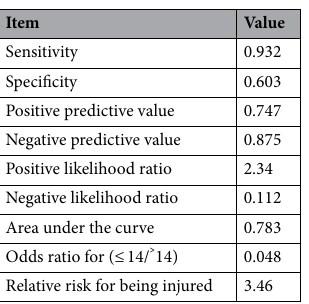
Table 3. Diagnostic value of the FMS test for predicting musculoskeletal injuries in volleyball players.